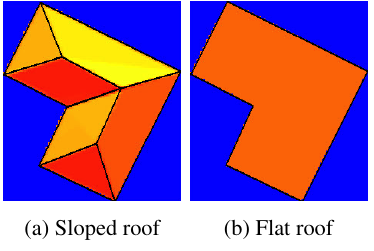
Figure 13: GIS Processing Steps